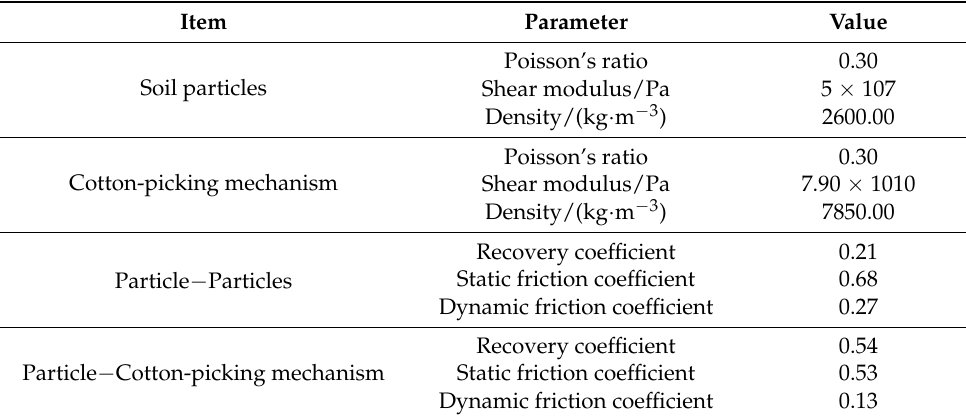
Table 2. Simulation parameter settings of soil particles and geometry.